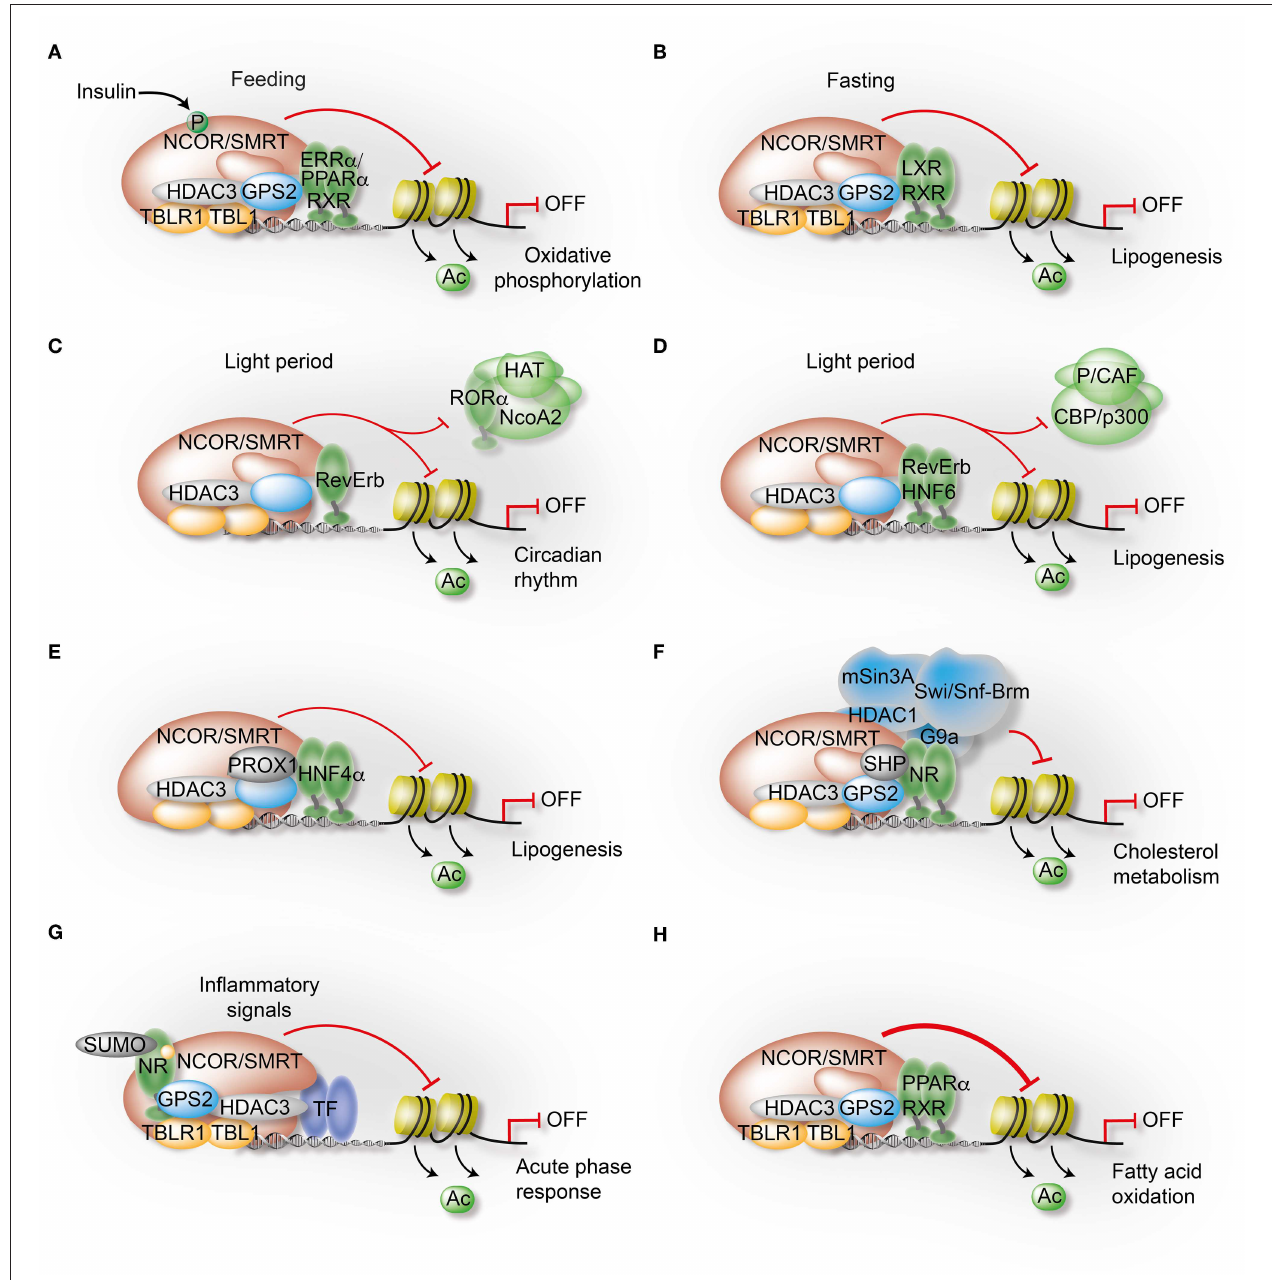
FIGURE 4 | Mechanisms governing the transcriptional control of liver metabolism by variable co-repressor sub-complexes. (A,B) NCOR selects its targets depending on the cellular energy status. Insulin induces phosphorylation of NCOR serine 1460, which selectively favors NCOR interaction with PPAR α and ERR α over LXR α . As a result, PPAR α /ERR α -dependent oxidative metabolism is attenuated due to repression (A) , while LXR α -dependent lipogenesis is increased due to de-repression (B) . (C) RevErb α recruits the NCOR-HDAC3 complex to its canonical DNA-binding motifs to repress circadian clock genes during the light period. (D) Simultaneously, HNF6 recruits RevErb α and the associated co-repressor complex to mediate circadian repression of lipogenic gene expression during the light period. (E) Immuno-precipitation-coupled mass spectrometry from mouse liver extracts identified interactions of the HDAC3 complex with the homeodomain co-repressor PROX1, which mediates the recruitment to HNF4 α -bound enhancers to repress lipogenesis. (F) The atypical orphan receptor SHP inhibits cholesterol metabolism by acting as a co-repressor for multiple NRs via distinct mechanisms, one involving interactions with the GPS2 subunit of the co-repressor complex. (G) GPS2 mediates trans-repression of the hepatic acute phase response by docking to SUMOylated LXR β and LRH1. As a consequence, inflammatory signals fail to release the co-repressor complex from chromatin and inflammatory gene expression remains repressed. (H) GPS2 and NCOR synergistically interact with PPAR α , thereby potentiating the repressive function of the co-repressor complex to inhibit PPAR α -dependent fatty acid oxidation.